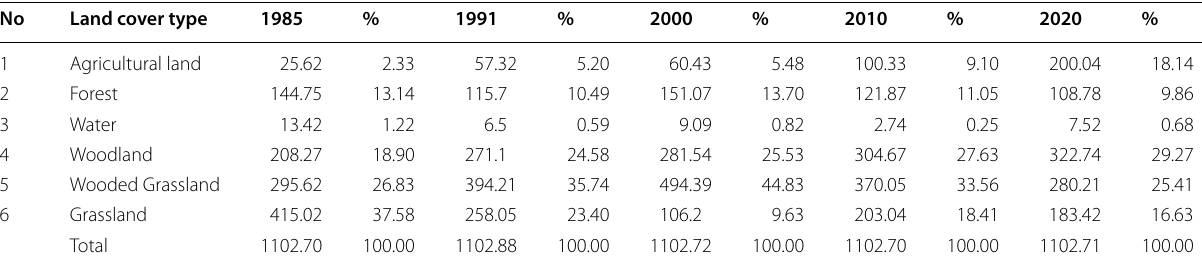
Table 4 Extents (in km 2 and %) of land use-land cover types in the buffer zone of the CCNP in each year